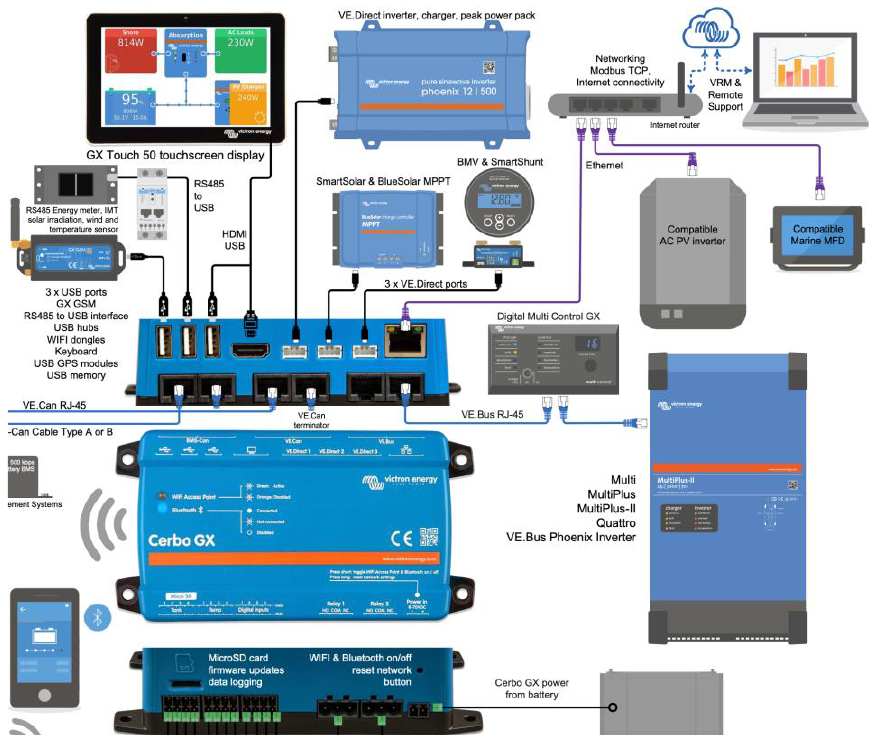
Figure 12. Cerbo GX cloud networking devices